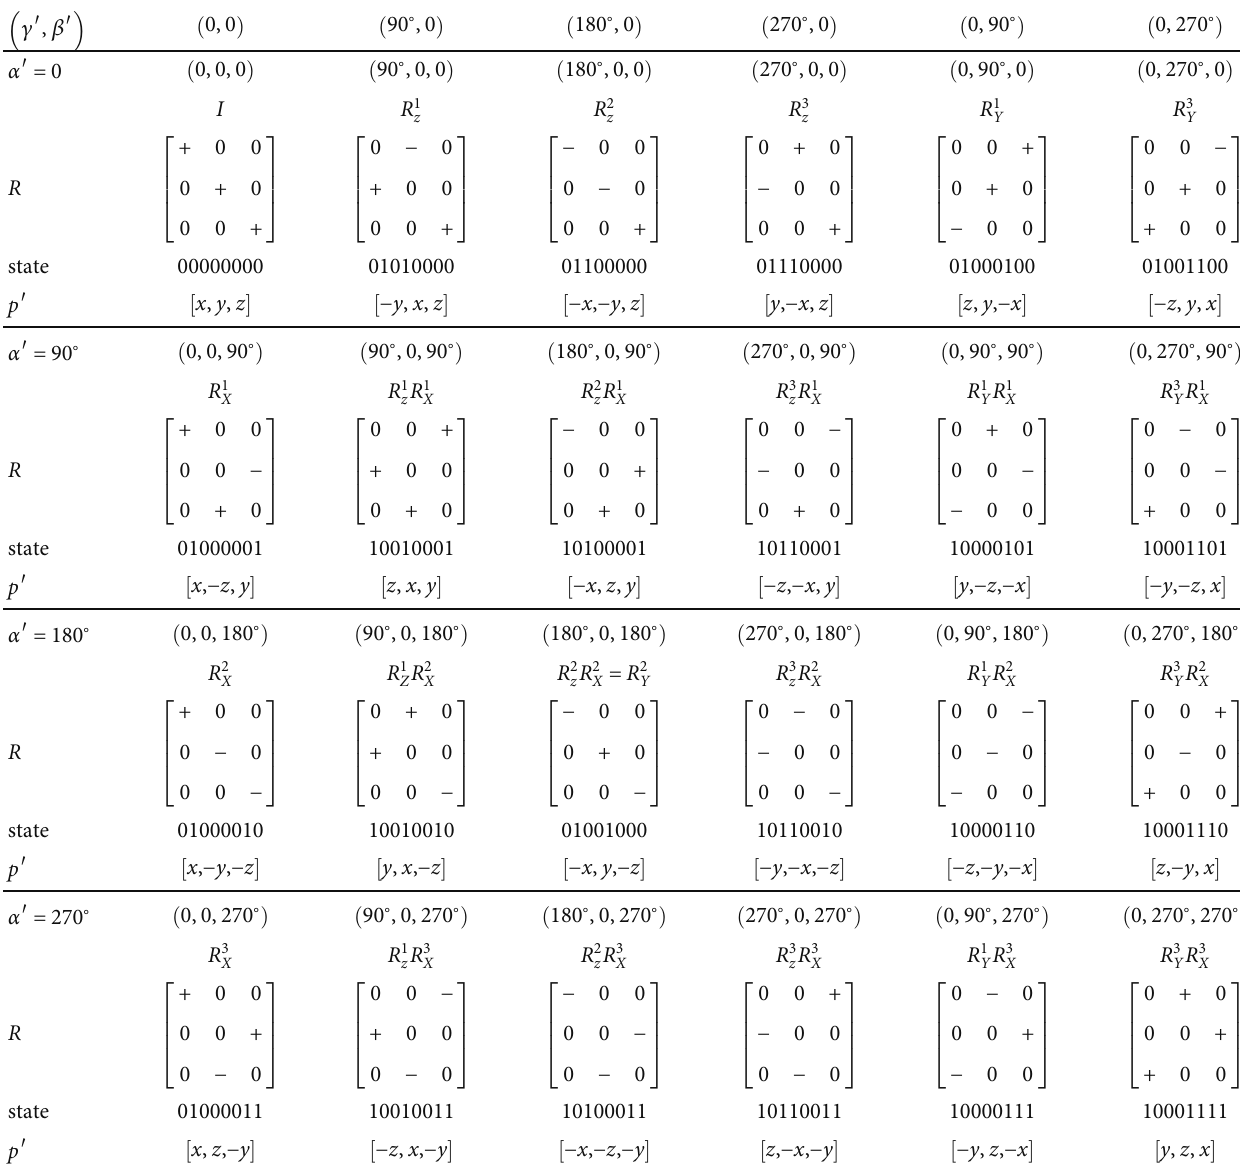
Table 2: Possible orientations of the cubie in the form of Euler angles ( α ′ , β ′ , and γ ′ ), matrix R , coded state , and cubie positions p ′ after transformation by rotation R